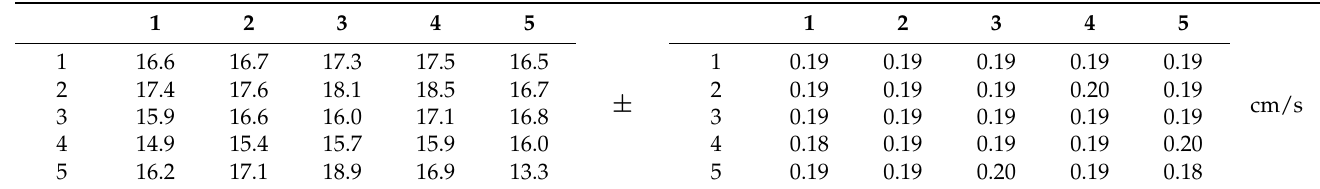
Table 6. Computed 𝑢 𝑗,𝑘 component in the middle plane and its conservative uncertainty (rounded Table 6. Computed u j , k component in the middle plane and its conservative uncertainty (rounded to to the 2nd decimal digit). the 2nd decimal digit).